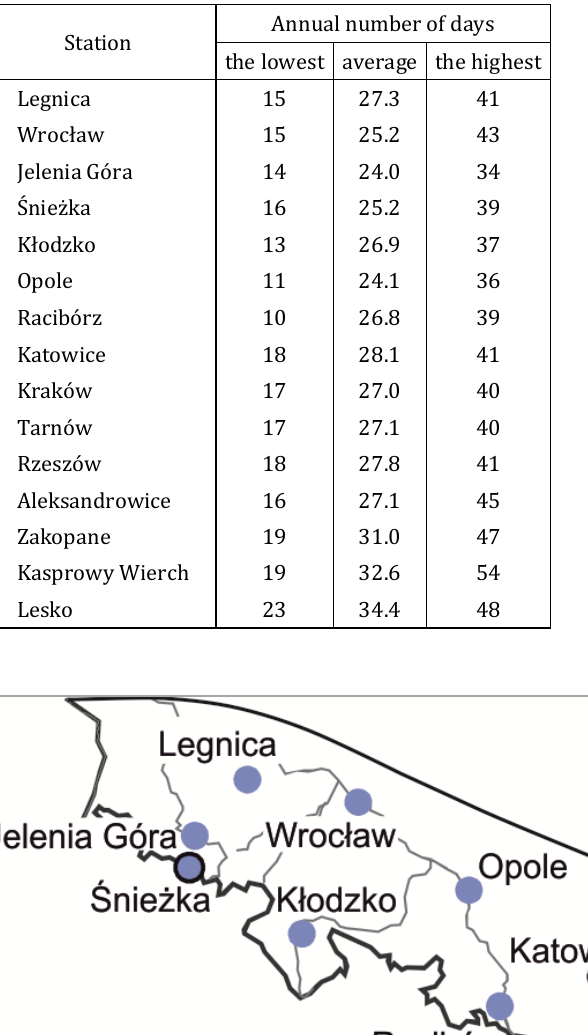
Table 1. Annual number of days with thunderstorm in the